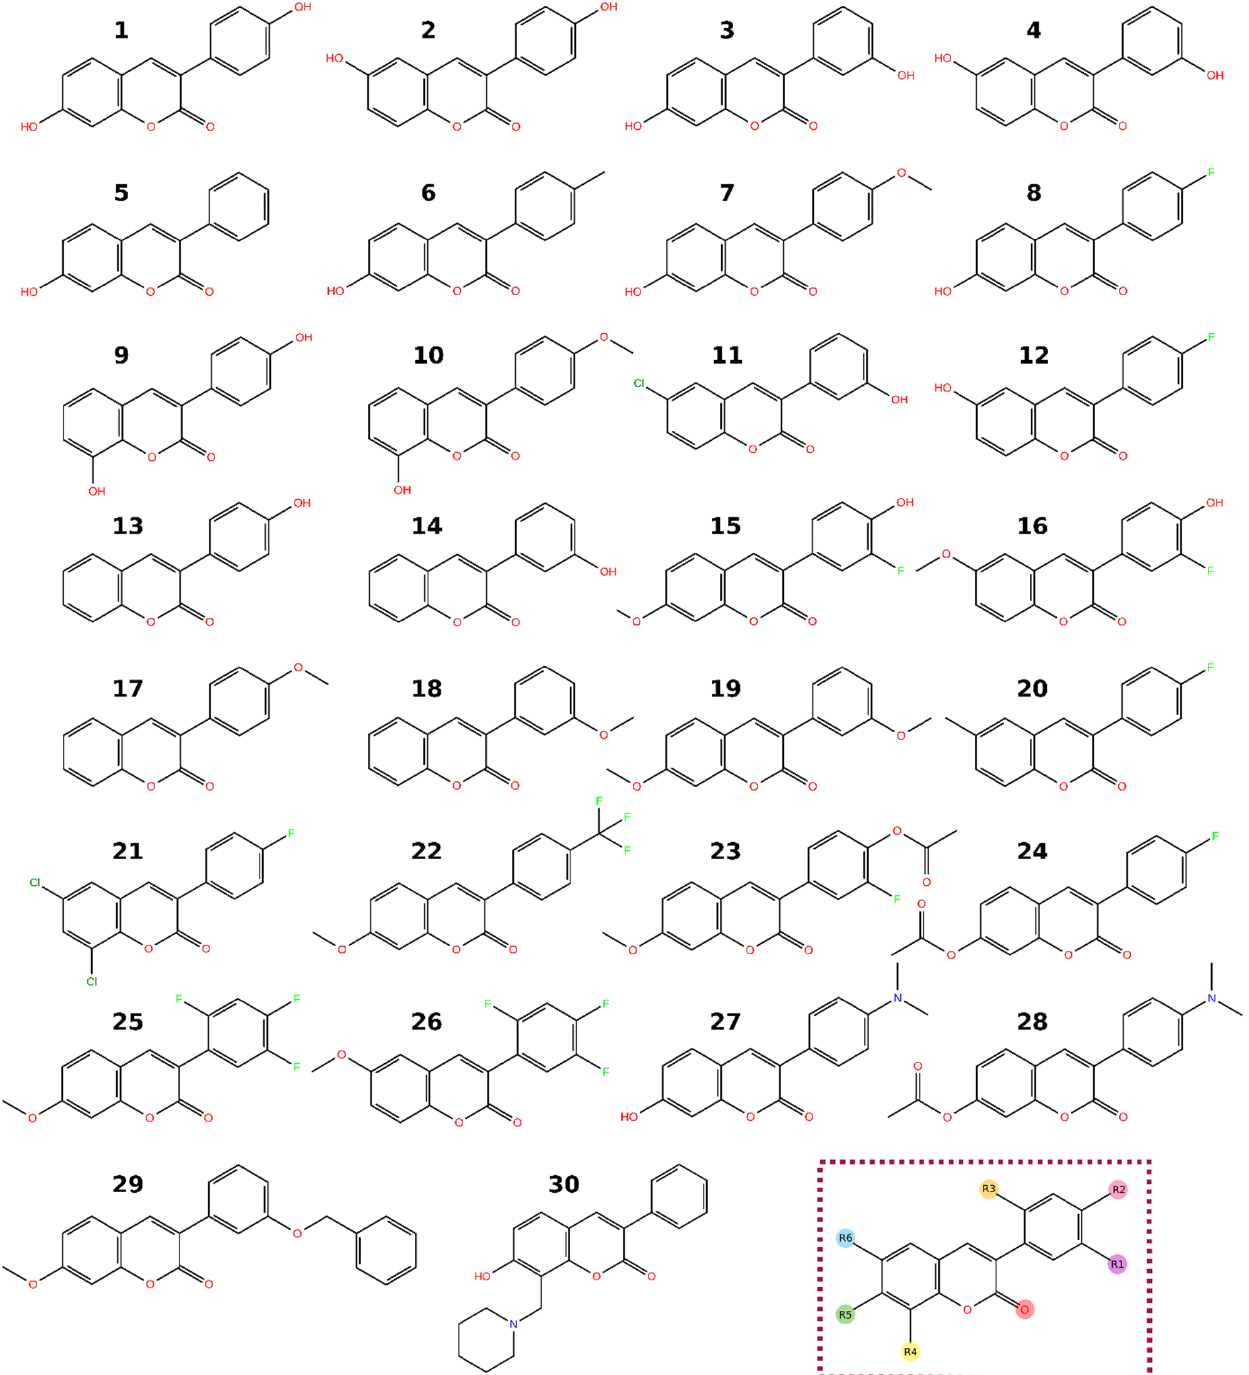
Figure 3. Structures of the studied 3-phenylcoumarin derivatives. Table 1. Inhibitory profiles of the 3-phenylcoumarin compounds *.